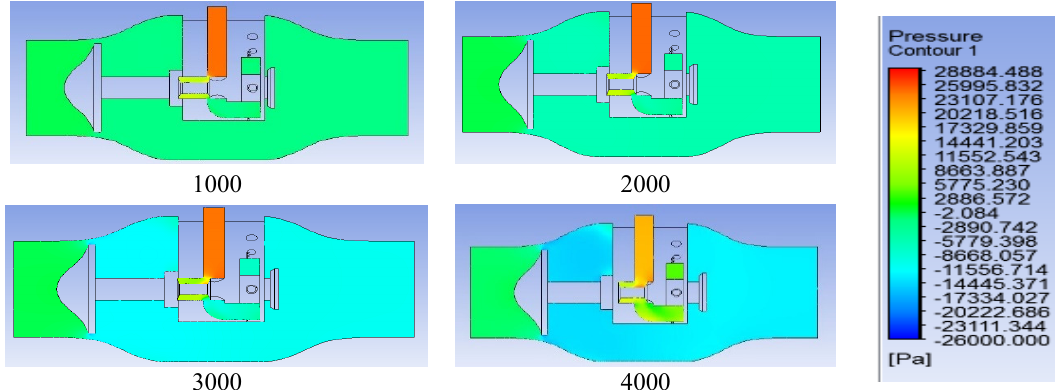
Figure 23. Distribution of static pressure on YZ plane inside the new mixer according to different engine speeds and constant air-CNG ratio (34.15).